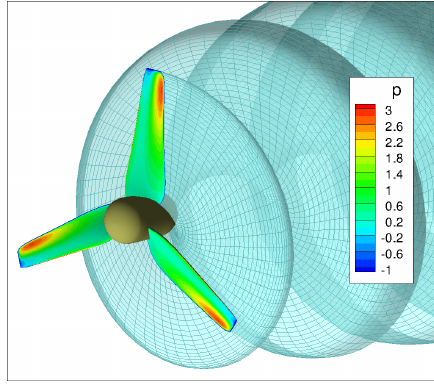
Fig. 11. Model turbine: 3D view of λ des = 4 . 2 rotor with trailing wake and blade pressure distribution evaluated by BIEM-VFC. The design TSR, λ des , is taken as a parameter that is varied between 2.6 and 7.0, and design loops for each λ des value are performed. With these problem settings, the design procedure delivers a family of rotor geometries corresponding to different λ des values.